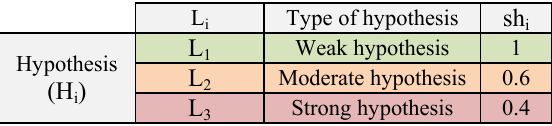
Table 1. Hypotheses levels